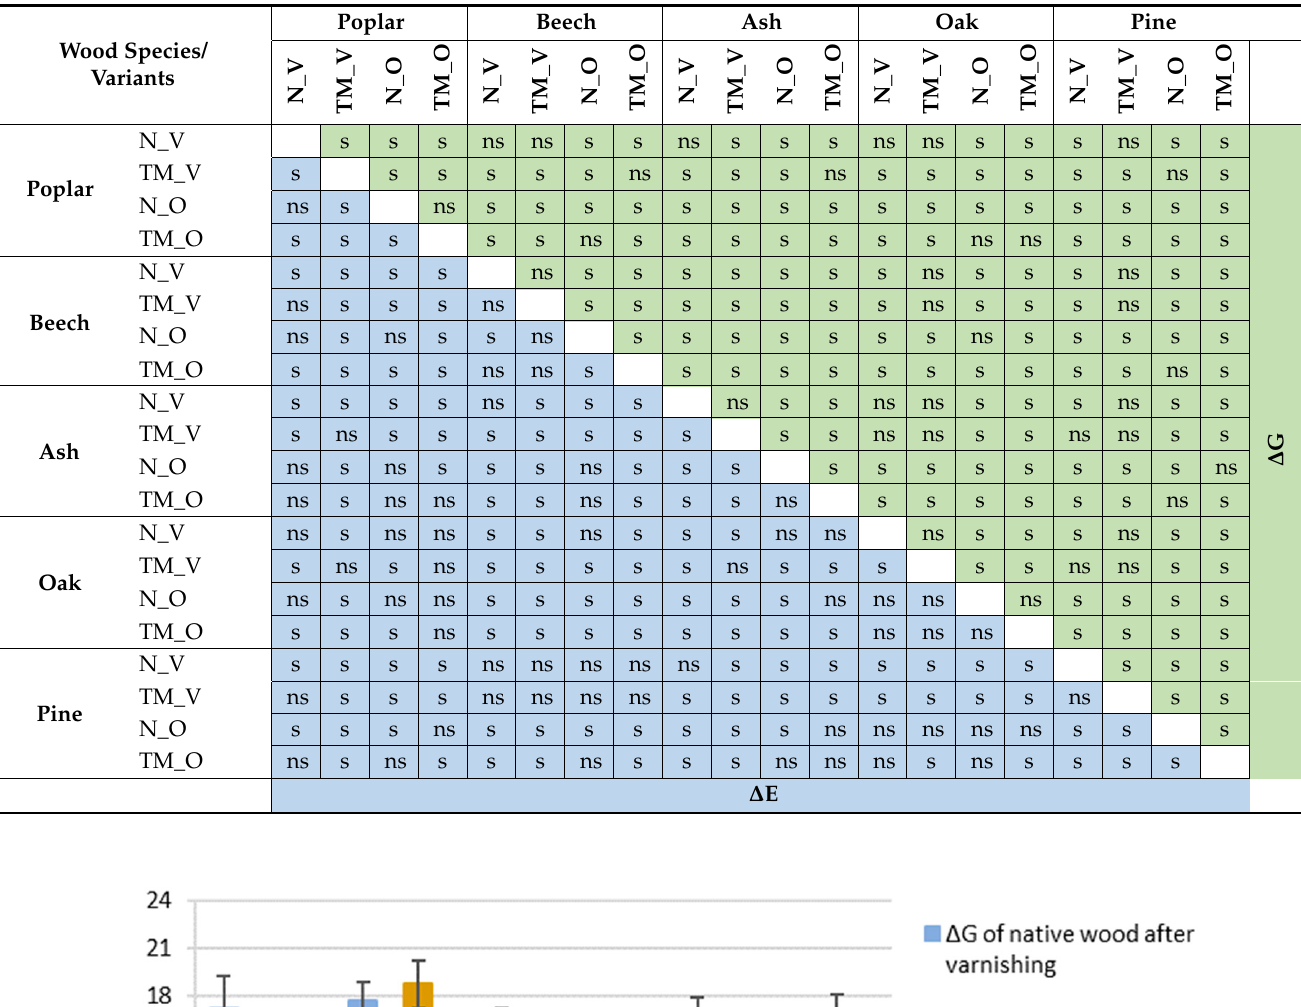
Table 4. Statistical analysis of the ∆ E and ∆ G results (s—significant differences, ns—no significant differences, based on the t -test, p ≤ 0.05).